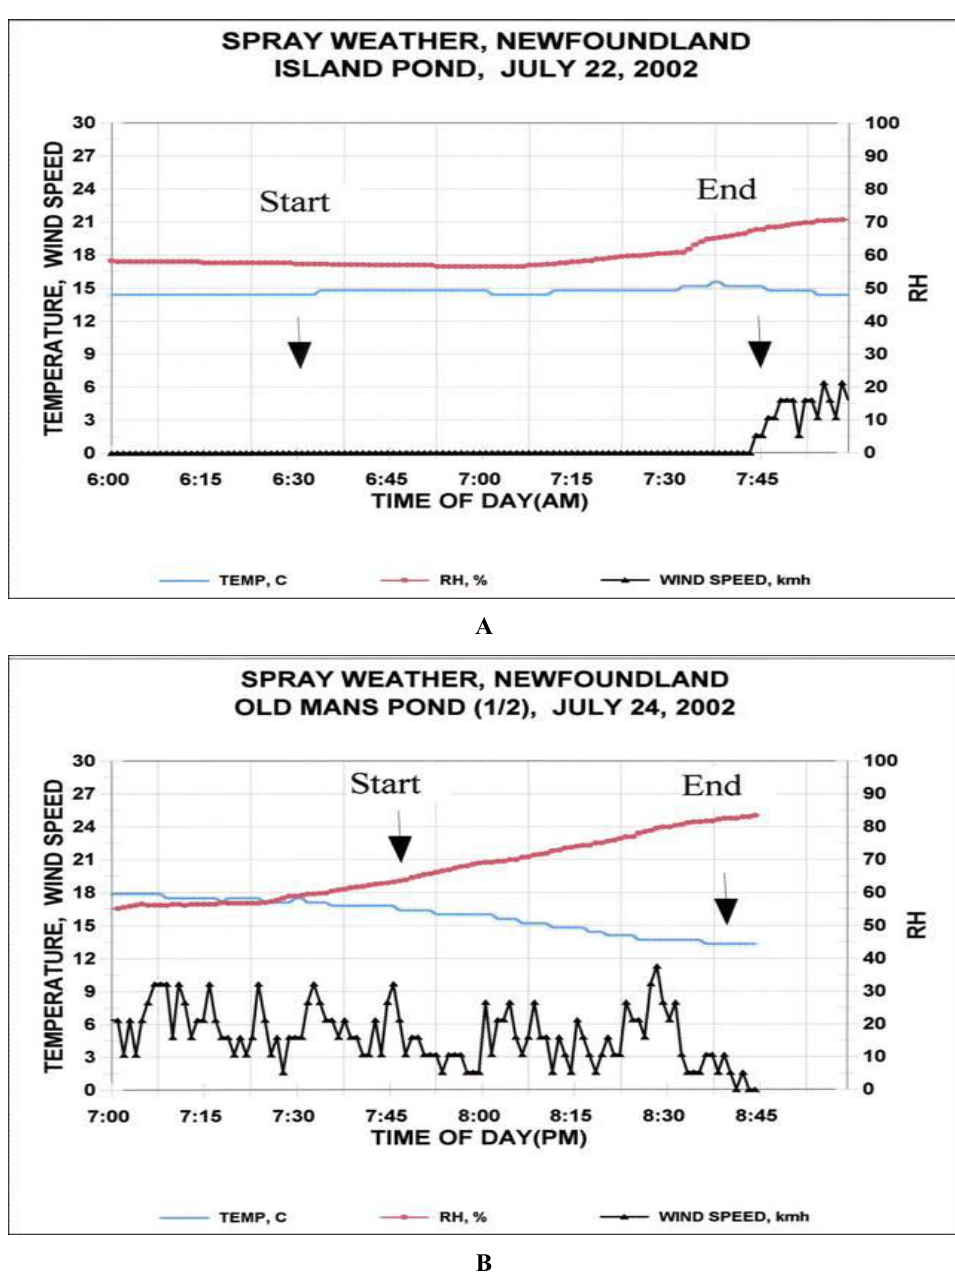
Figure 2. Wind speed, temperature, and relative humidity during the periods of NeabNPV aerial spray operations on 22 July 2002, at ( A ) Island Pond and on 24 July 2002, at ( B )